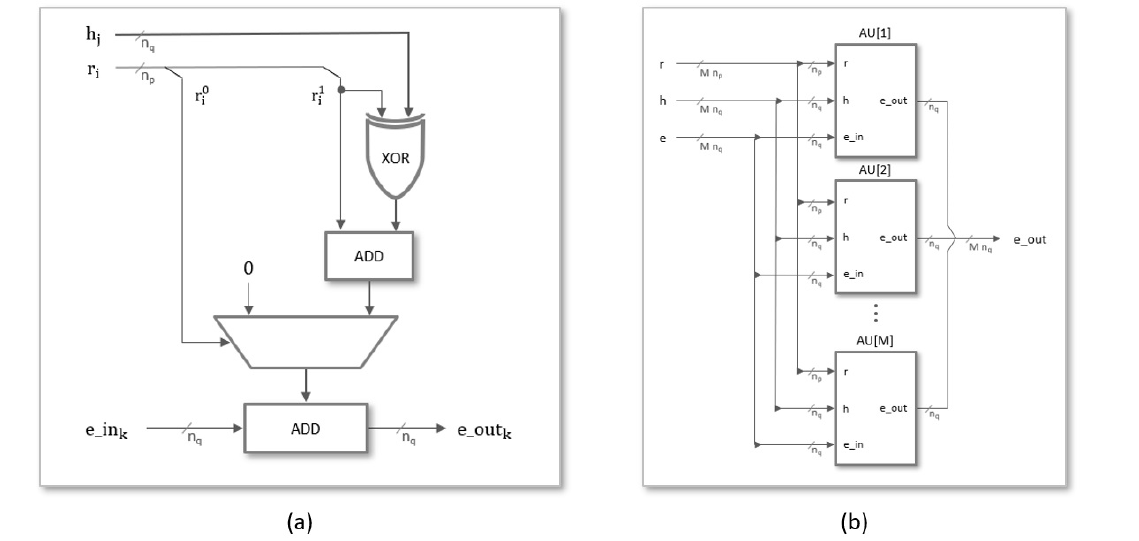
Figure 9. Block diagram of the arithmetic unit ( a ) and grouping of M arithmetic units to calculate M terms of the multiplier operation in parallel ( b